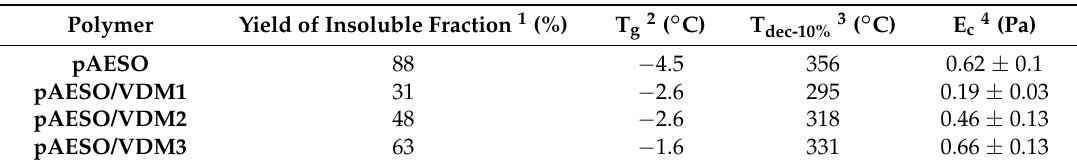
Table 3. The yield of the insoluble fraction and the thermal and mechanical characteristics of the cross-linked polymers.